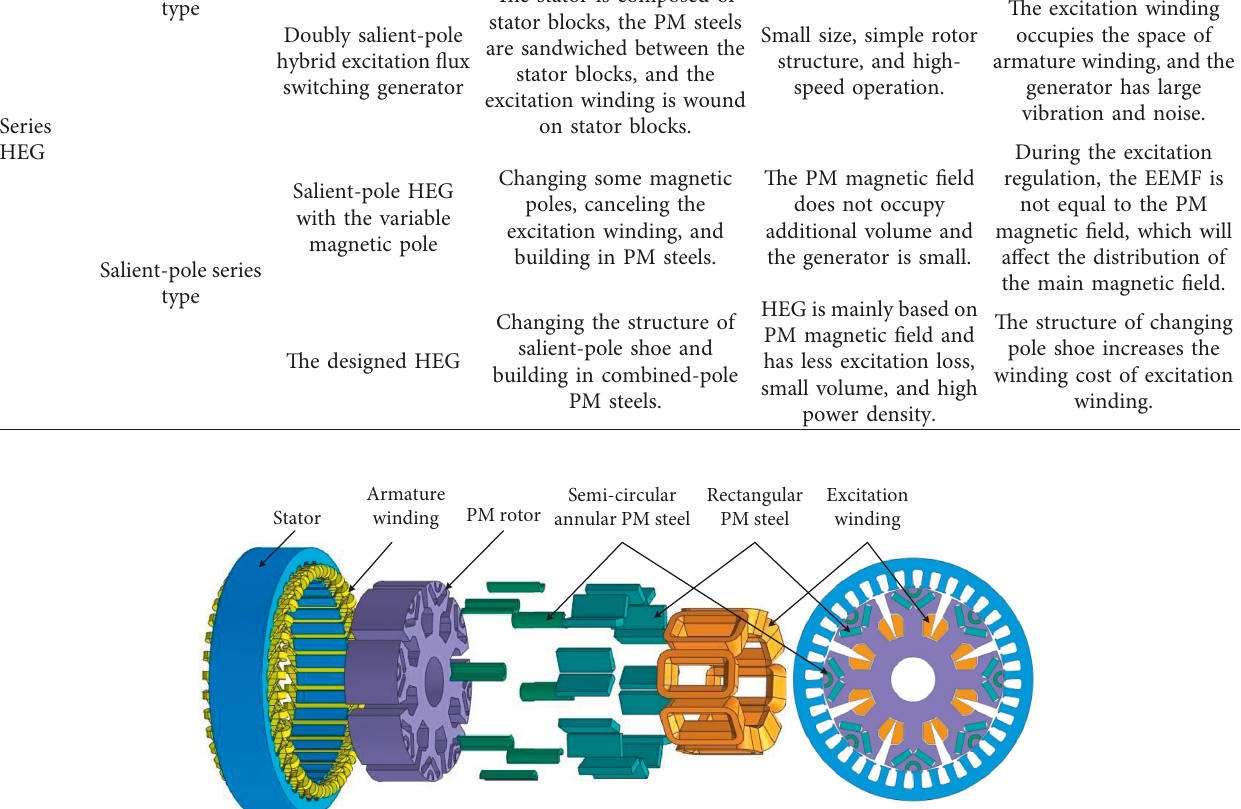
Figure 1: The structure of the designed HEG.